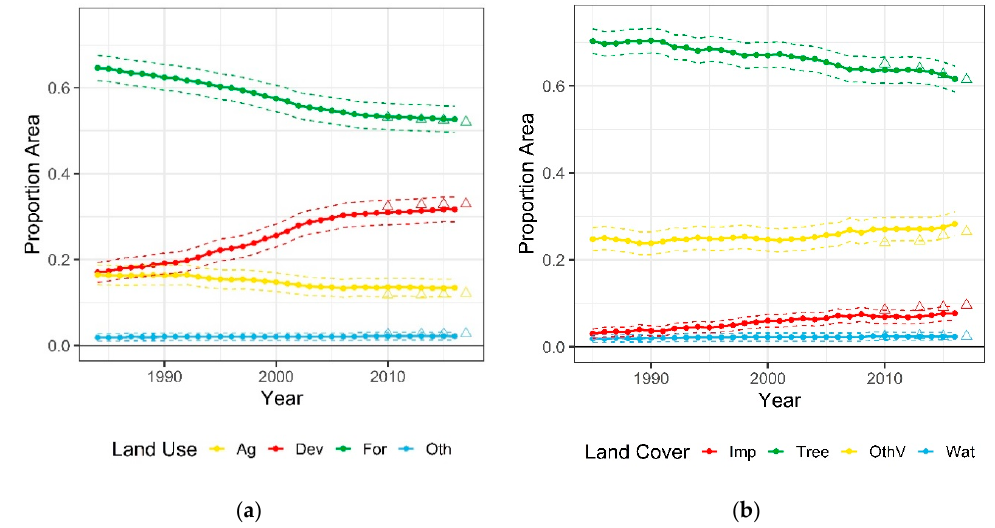
Figure 6. ( a ) The estimated proportion of land area in forest (green), agriculture (yellow), developed (red), and other (blue) land use, with 95% confidence intervals, by year, using TimeSync observations. ( b ) The estimated proportion of land area in tree (green), other vegetation (yellow), barren and impervious (red), and water (blue) land cover, with 95% confidence intervals, by year, using TimeSync observations. ICE estimates are superimposed on both graphs as open triangles.